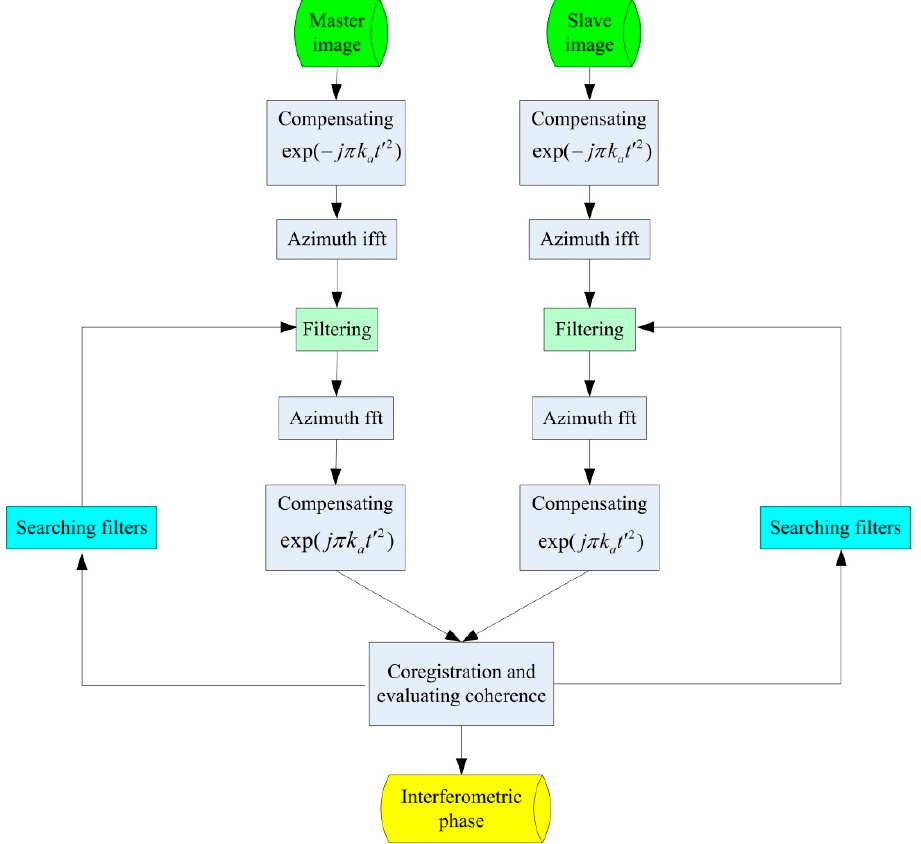
Figure 1. The iterative filtering method diagram.